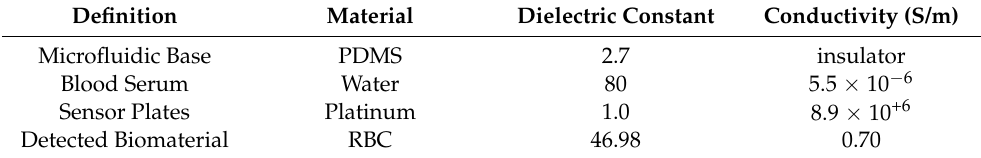
Table 2. Dielectric constants and conductivity of materials used for